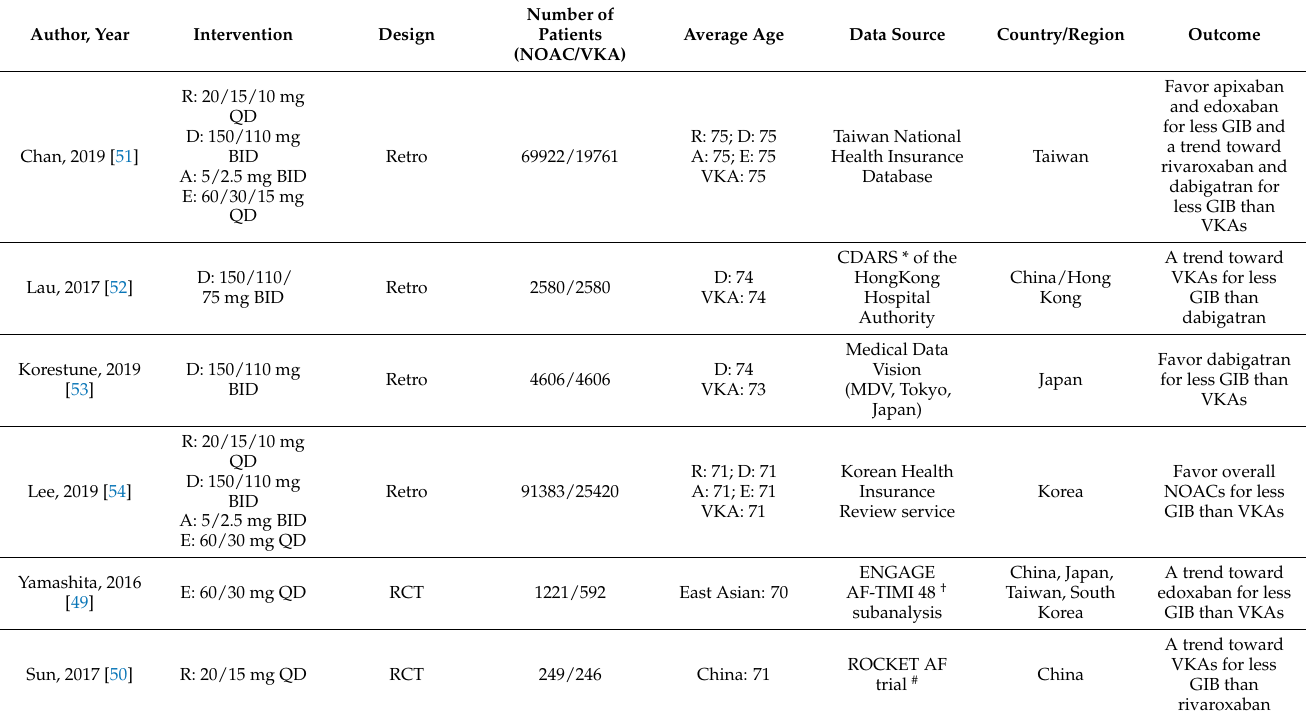
Table 1. Summary of the retrieved articles for gastrointestinal bleeding risk of non-vitamin K antagonist oral anticoagulants and vitamin K antagonists in the Asian atrial fibrillation